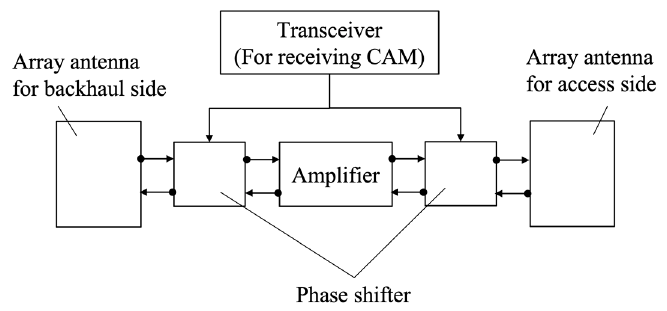
Figure 2. Architecture of the analog RN in massive analog-relay MIMO.